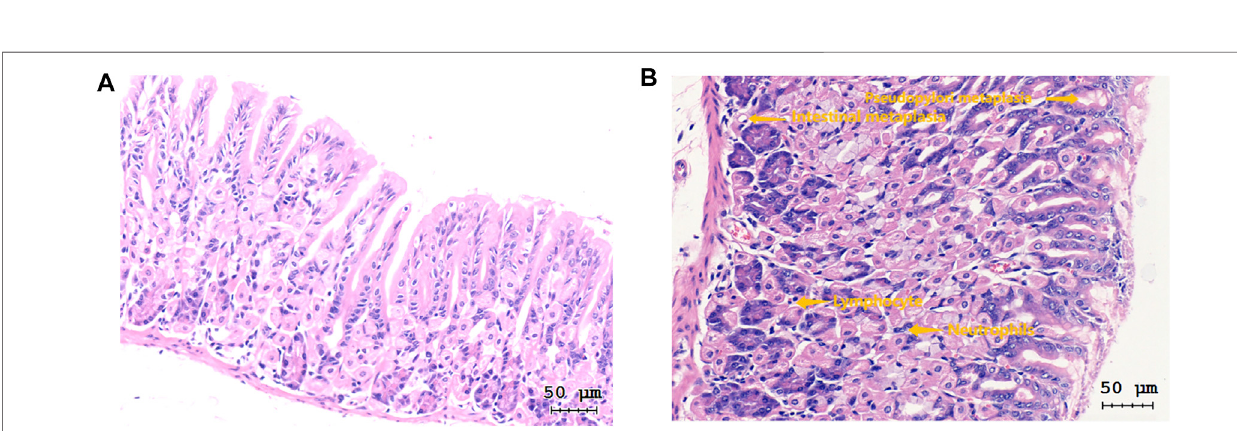
Frontiers in Pharmacology |